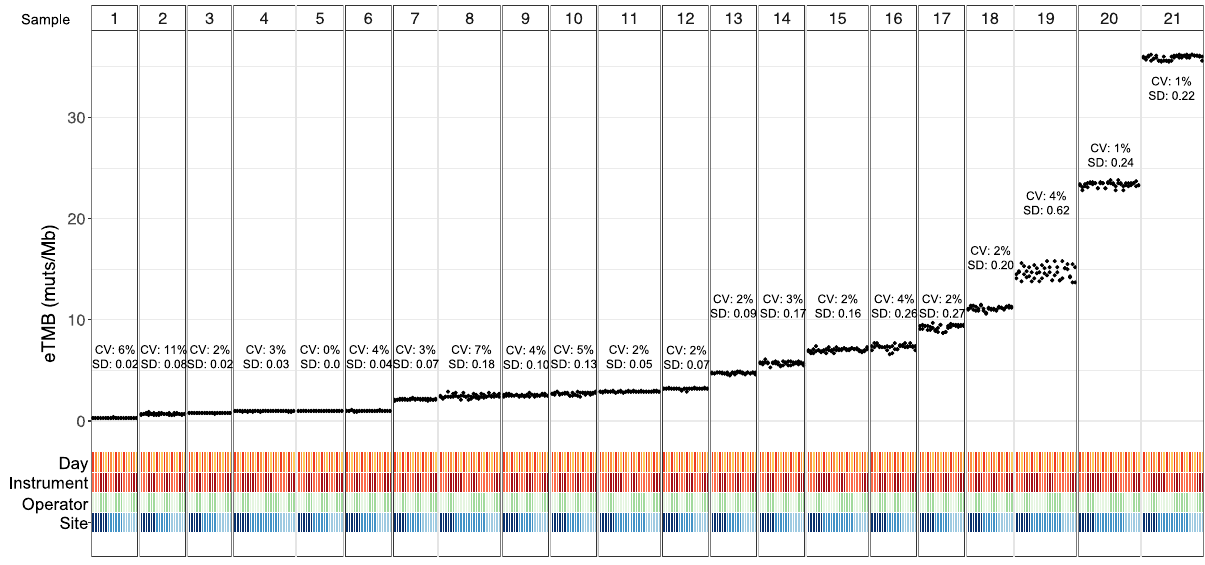
Fig. 4 Analytical precision and reproducibility of elio tissue complete eTMB. Precision and reproducibility of elio-predicted exome tumor mutation burden (eTMB) measured in mutations per megabase (muts/Mb) across three independent clinical laboratories using 21 FFPE tumor and cell-line samples. At each site, each sample was analyzed by two operators on two sequencing instruments across three non-consecutive days as indicated. The coef fi cient of variation (CV) and standard deviation (SD) for each sample are indicated, demonstrating high performance of eTMB across standard clinical laboratory variables. Source data are provided as a Source Data fi